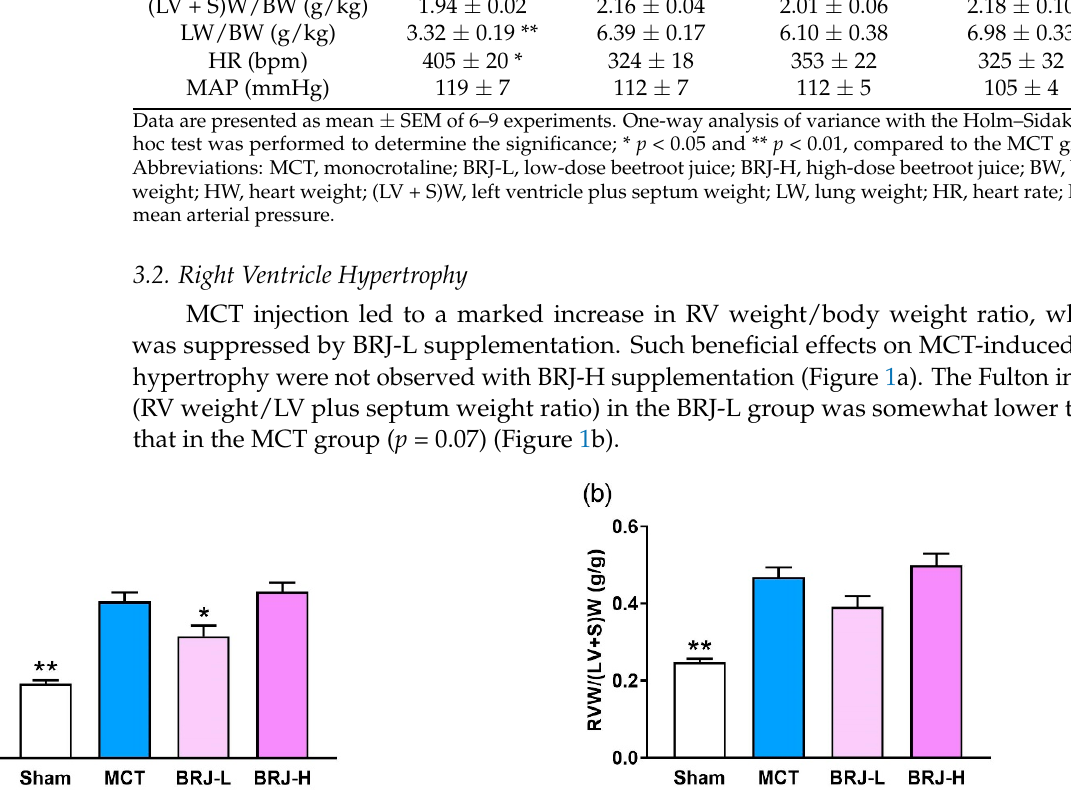
Figure 1. Effects of BRJ supplementation on RV hypertrophy in MCT-injected rats. ( a ) RVW/BW, ( b ) RVW/(LV + S)W. Each column and bar represent the mean ± SEM values of 6–9 experiments. One-